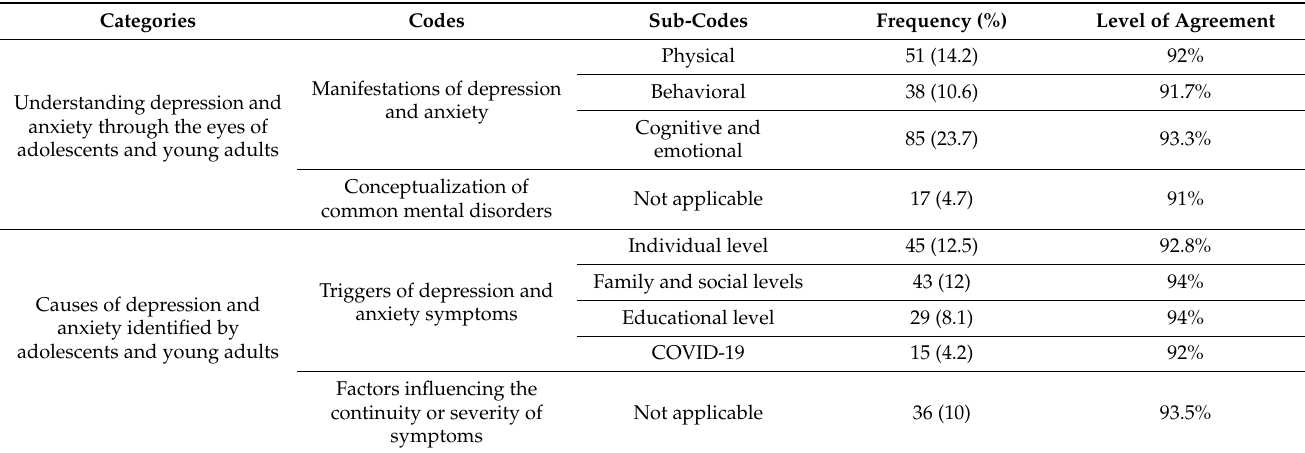
Table 2. Percentage agreement between coders and the percentage of passages in which the coding categories